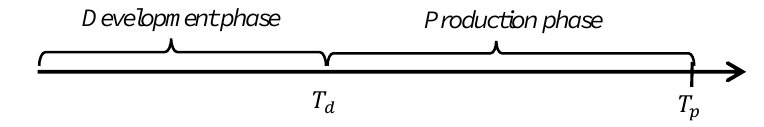
Figure 1. Schematic view of Buy-back service